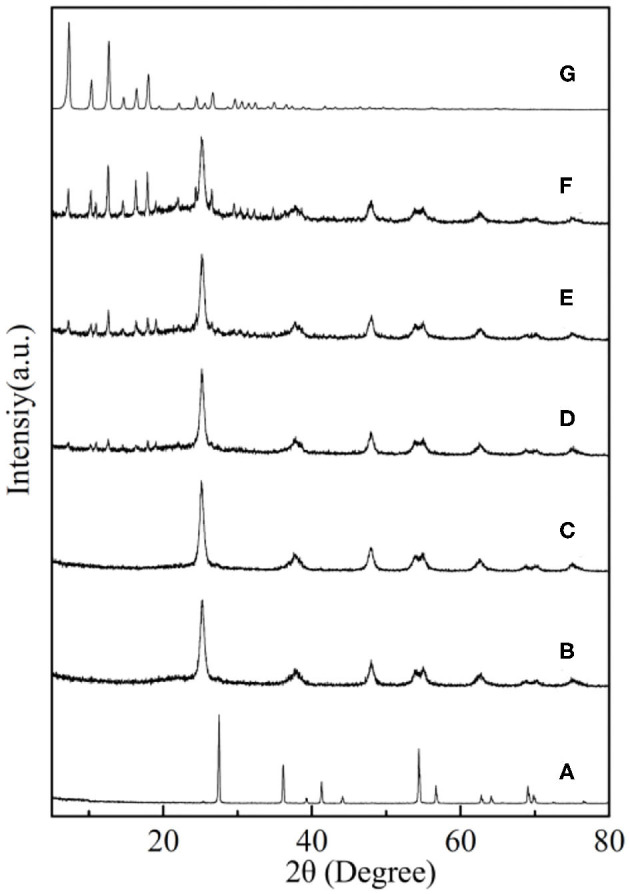
XRD patterns of (A) TiO2, (B) core–shell SiO2@TiO2 nanoparticles, (C) hollow TiO2 nanoparticles, and (D) HTZ-1, (E) HTZ-2, (F) HTZ-3, and (G) ZIF-8.